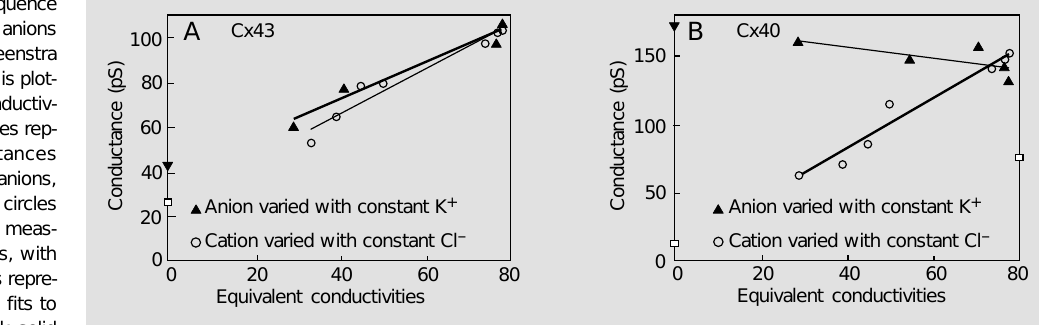
Figure 1 - A , Selectivity sequence of Cx43 for cations and anions taken from Wang and Veenstra (20). Unitary conductance is plot- ted against equivalent conductiv- ity (cm 2 /Ohm). The triangles rep- resent unitary conductances measured with different anions, with K + as the cation. The circles are unitary conductance meas- ured with different cations, with Cl - as the anion. The lines repre- sent the linear regression fits to the data points. The thick solid line is the fit for the anions while the thinner line is for the cations. The y-intercept for the anions represents the conductance due to K + (41 pS) while the y-intercept for the cation data represents the Cl - conductance (27 pS). B , Cx40 taken from Beblo and Veenstra (23). The analysis is the same as that for Cx43. With constant K + as the anion species, increases in size and decreases in mobility resulting in increased channel conductance imply a cation/anion interaction for the more mobile anions which reduces conductance. The y-intercepts again represent the cation conductance (171 pS) and anion conductance (8 pS),